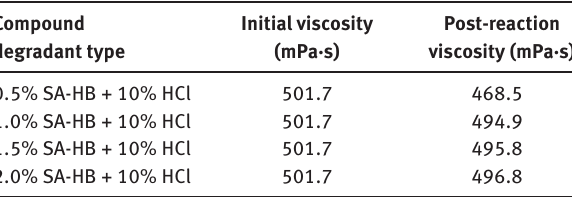
Table 8: Degradation effect of different concentrations of SA-HB.